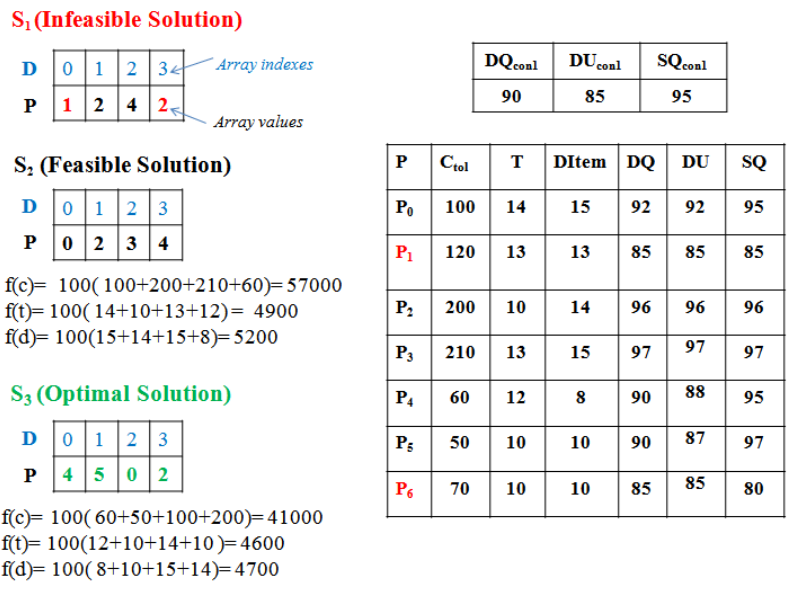
Figure 2. Example of three solutions (infeasible, feasible, and optimal solution) of the proposed model. Algorithm 1 Repair solution algorithm